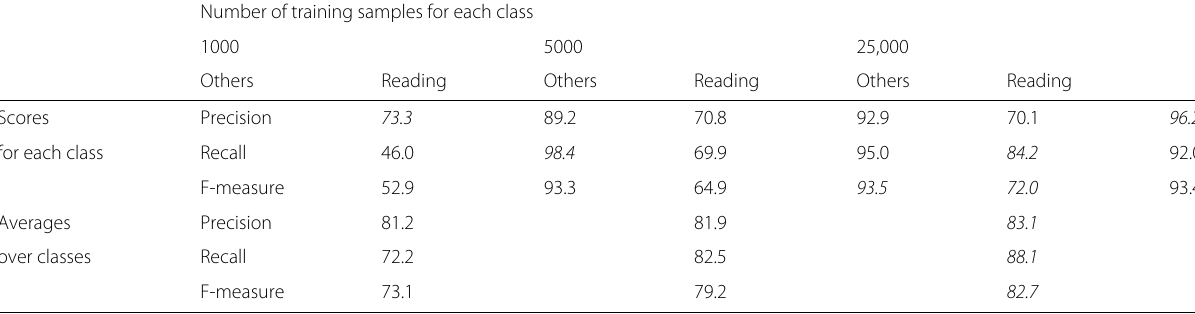
Table 7 Effect of changing the number of training